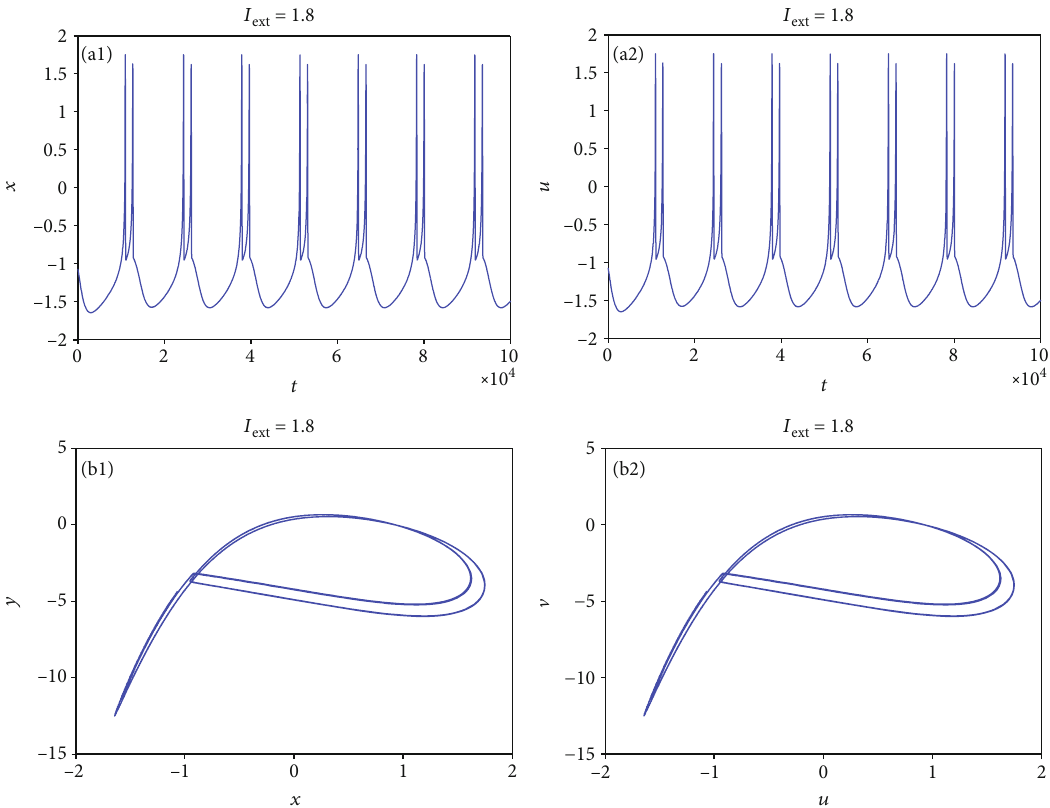
= 1 : 8 and k = 0 : 1 . (a1 and a2) Firing patterns of membrane potentials. (b1 and b2) ext